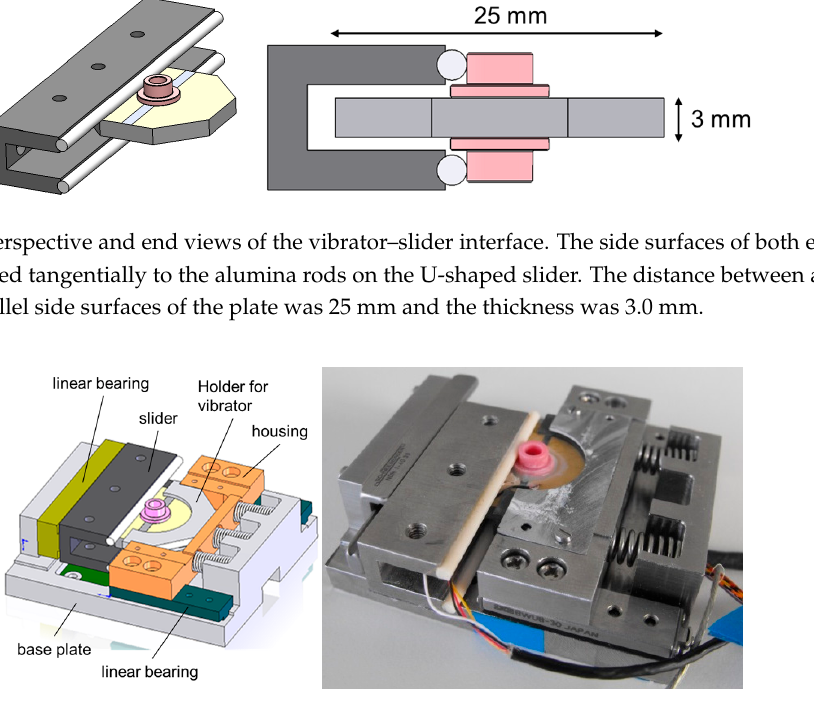
Figure 12. Response of the trajectory to the phase shift between the signals on the top and bottom electrodes.